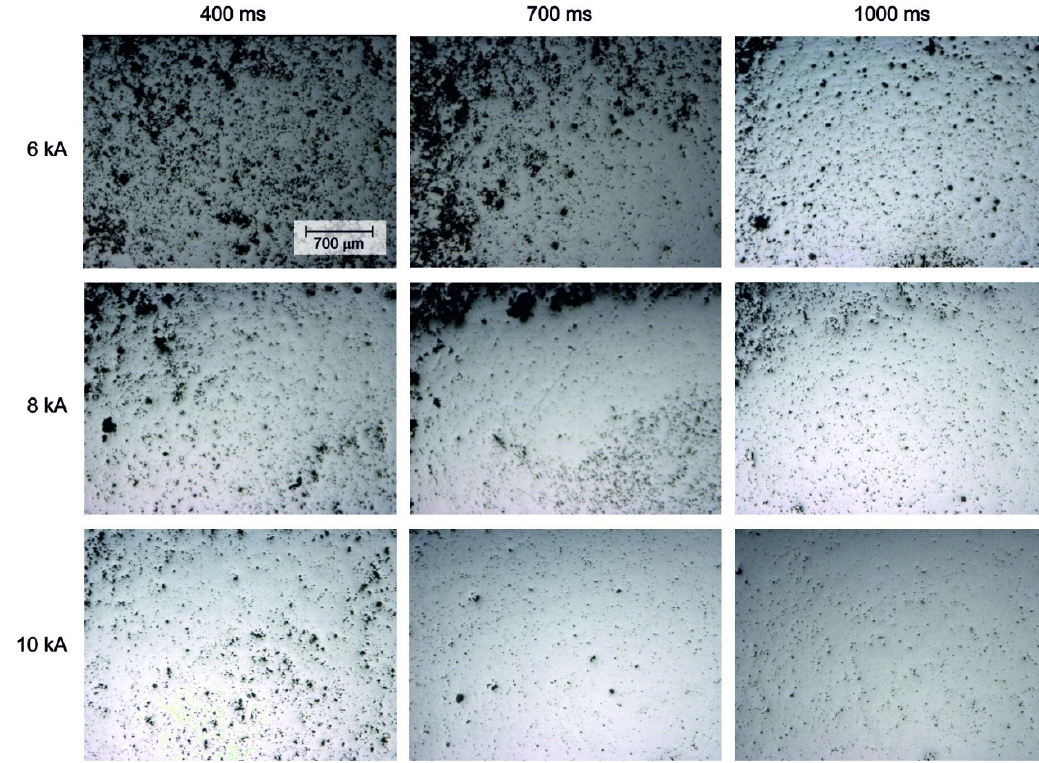
Figure 11. Micrographs showing the porosity distribution in a corner of diametrical sections of MF-ERS compacts consolidated under different conditions.